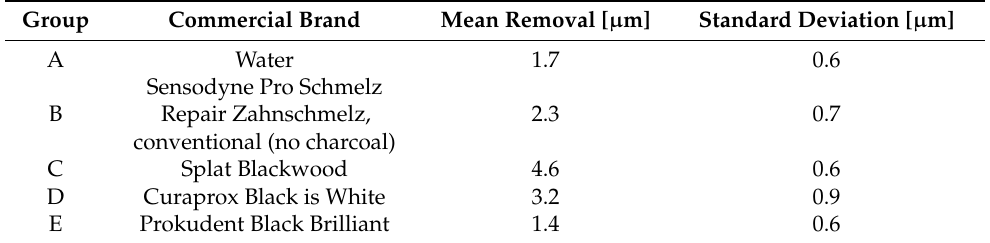
Table 2. Calculated enamel removal after brushing with different